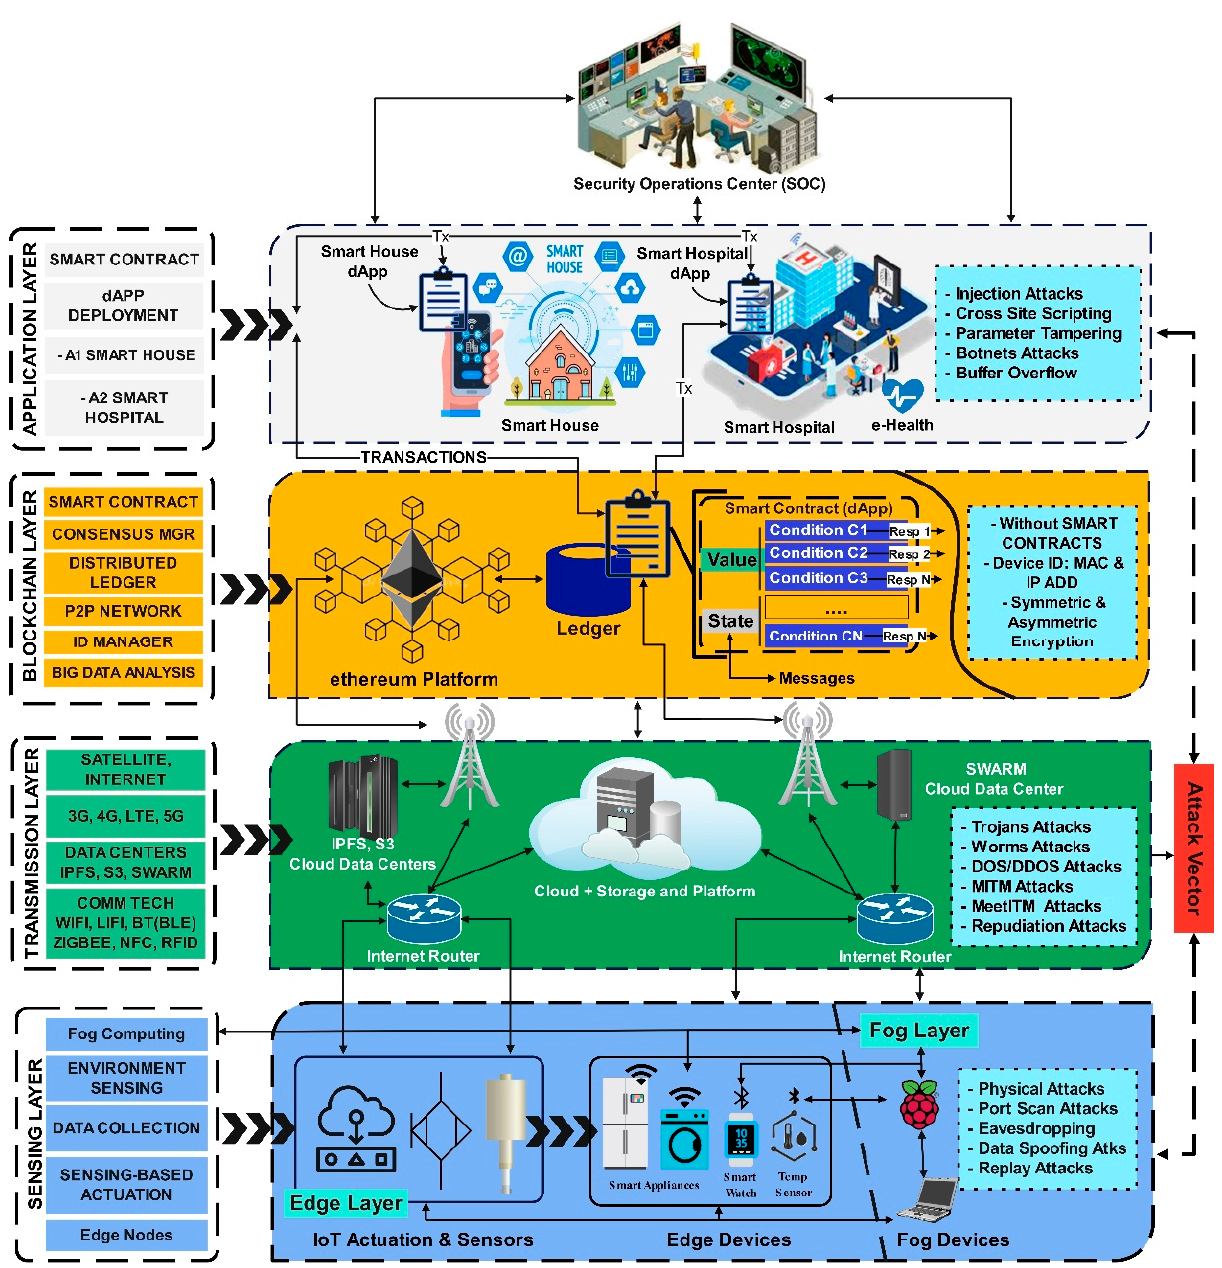
Figure 5. Blockchain-based Smart City Architecture.